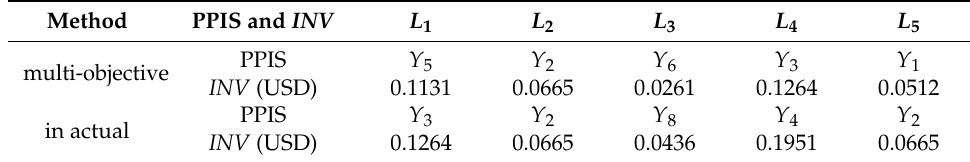
Table 3. Matching results and investment ( INV) comparison for the proposed method and the